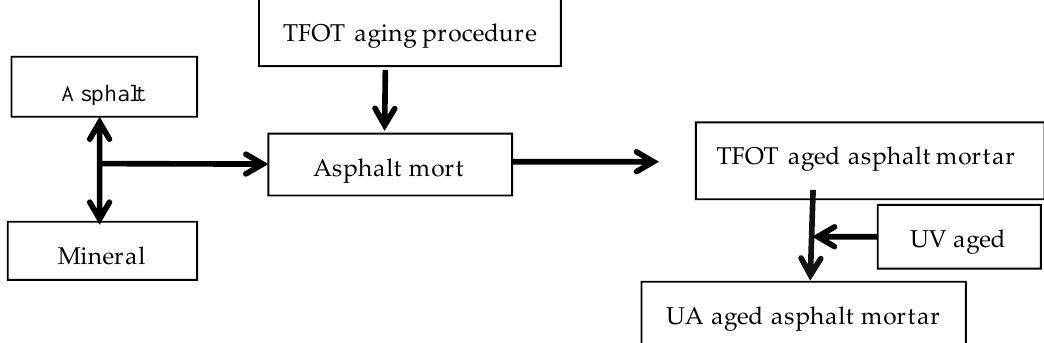
Figure 2. Preparation chart of asphalt mastic.